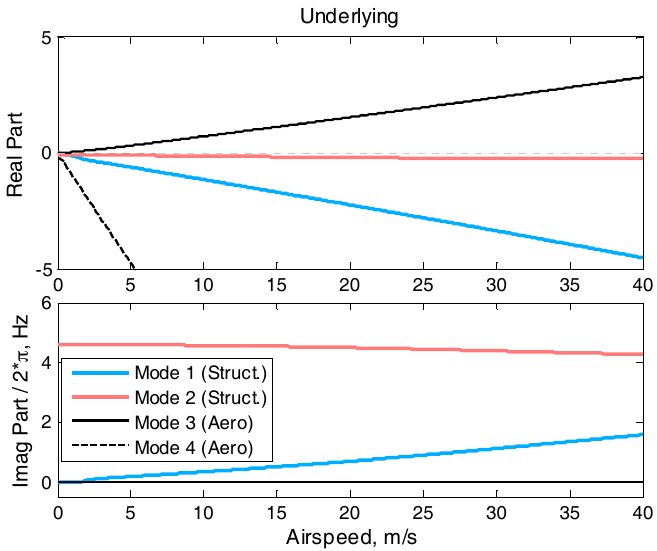
Figure 11. Eigenvalues of the underlying linear system (ULS) of the wing section model varying with the flow velocity.